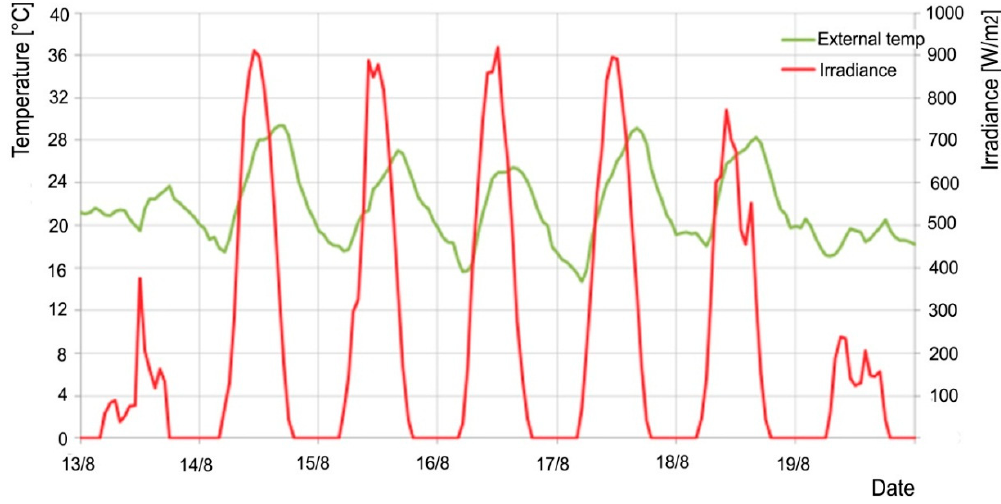
Figure 4. Weather data.